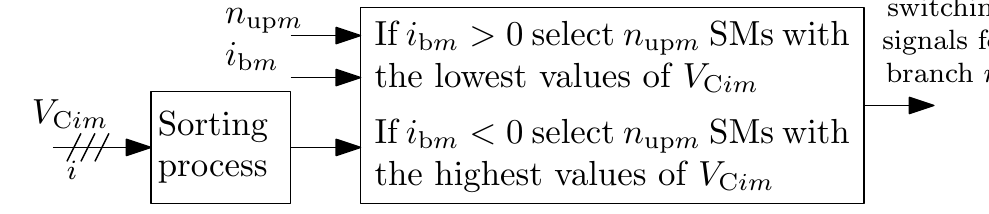
Figure 4. NLC VBA flowchart.